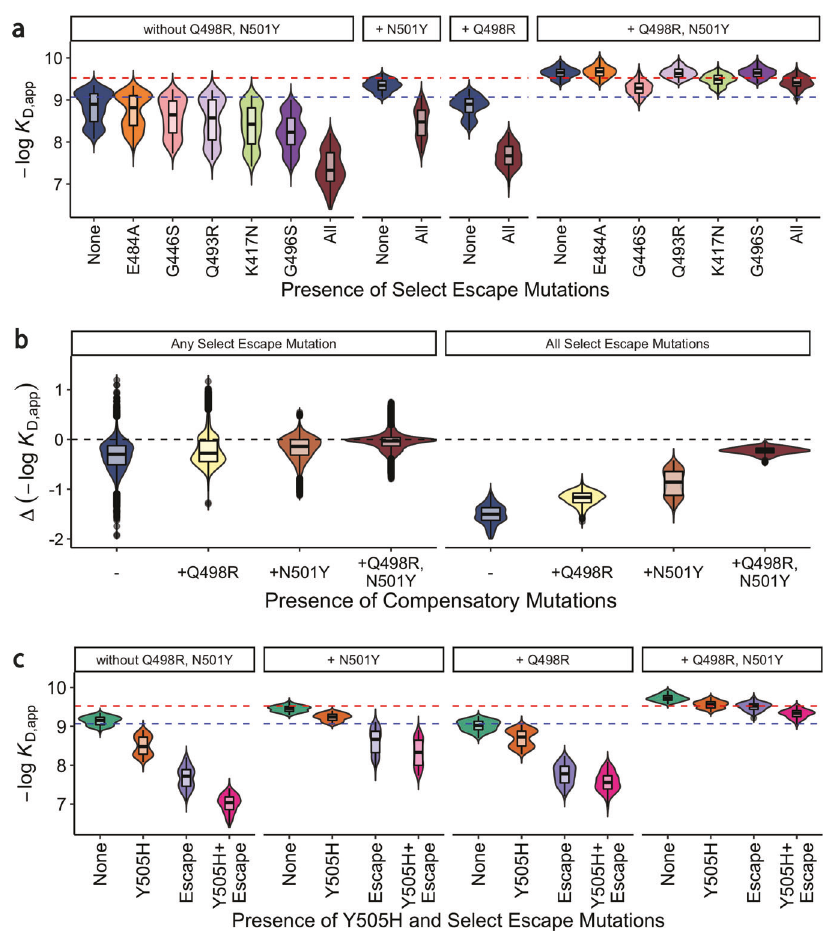
Fig. 3 | Epistasis compensates for reductions in ACE2 af fi nity. a ACE2 binding af fi nities for variants containing mutations that have a strong effect on antibody escape: K417N, G446S, E484A, Q493R, and G496S grouped by the presence of compensatorymutations(Q498RandN501Y).Dashedblue(resp.red)lineindicates Wuhan Hu-1 (resp. Omicron BA.1) ACE2 binding af fi nity. Boxes represent the